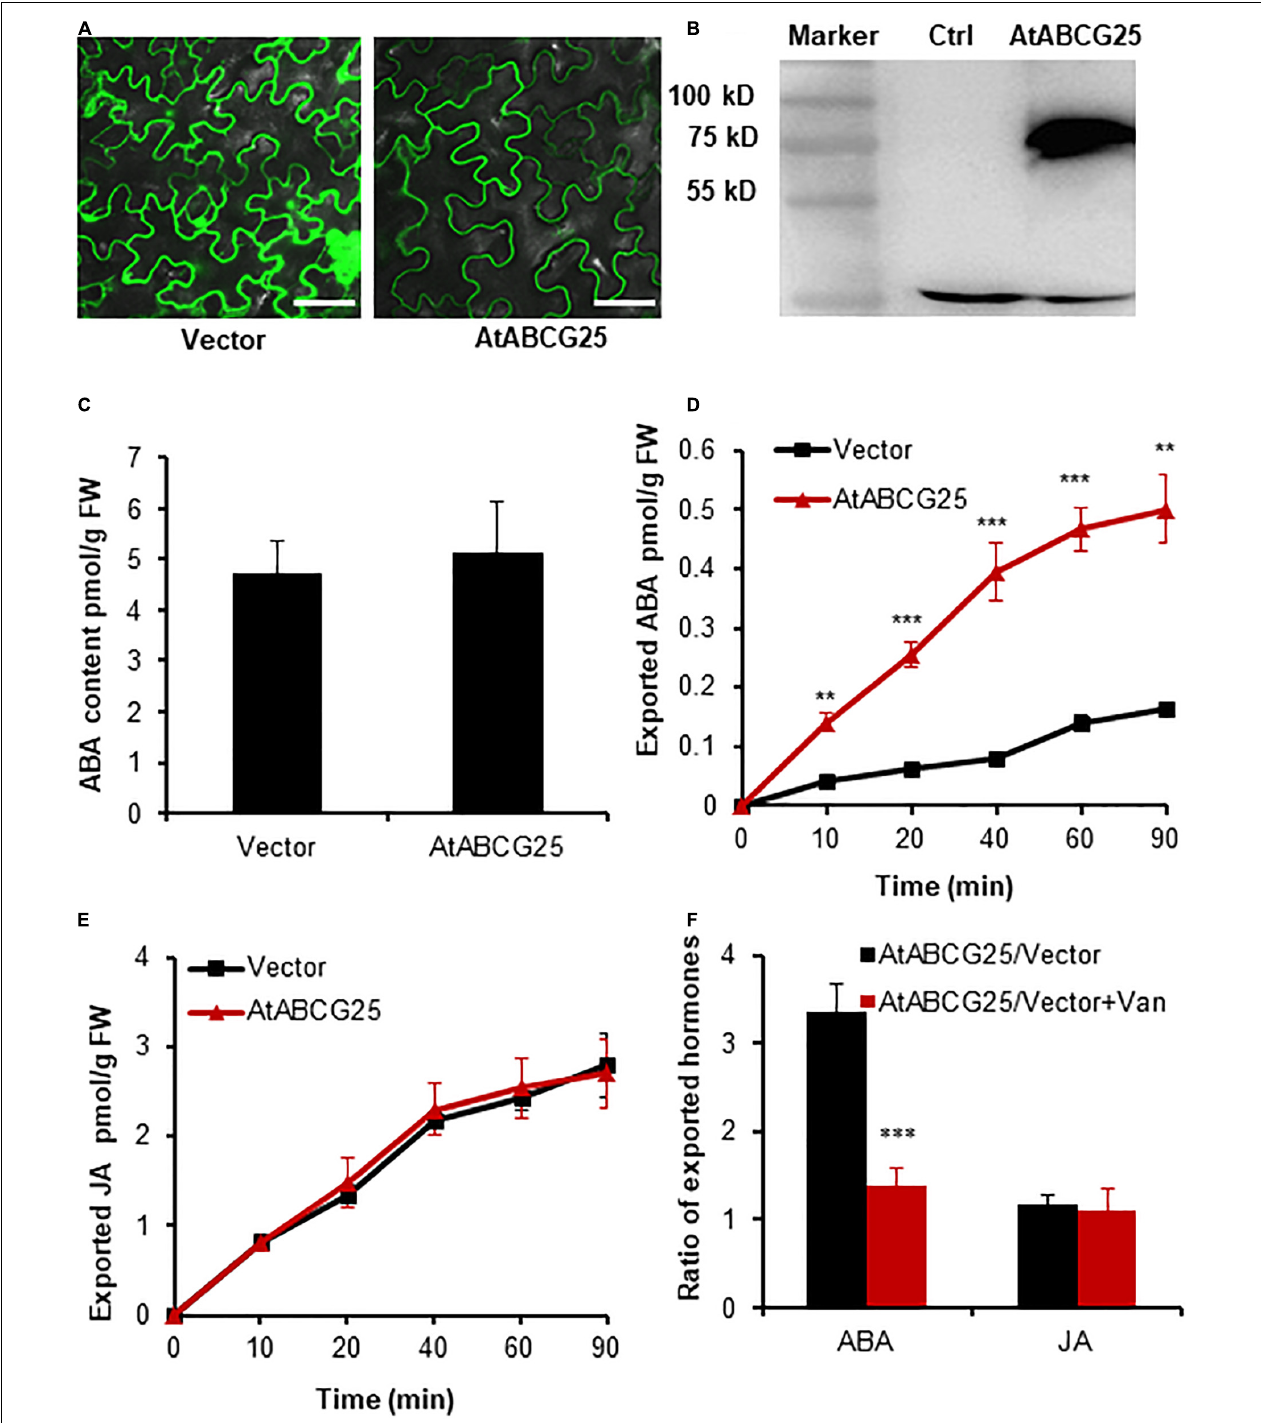
FIGURE 2 | AtABCG25-mediated efflux transport of ABA in agroinfiltrated tobacco leaves. (A) Transient expression of GFP and GFP-ABCG25 in tobacco leaves imaged by a confocal microscope. Bar = 50 µ m. (B) Immunoblot analysis of GFP - AtABCG25 fusion protein expression in tobacco leaves. M, marker; G25, total protein from tobacco leaves with transient expression of 35S:GFP-AtABCG25 ; Ctrl, control, total protein from non-transgenic tobacco leaves. (C) Quantification of ABA in tobacco leaves infiltrated with GV3101 harboring an empty vector and GFP-ABCG25 before efflux experiment. (D,E) Quantification of exported ABA (D) and JA (E) from tobacco leaves transformed with GFP-AtABCG25 and free GFP at the time points of 0, 10, 20, 40, 60, and 90 min. (F) The ratios of exported ABA and JA from tobacco leaves expressing GFP-AtABCG25 and free GFP in the presence or absence of 1 mM of sodium vanadate at 60 min. Data are means ± SE ( n = 4). *, **, and *** indicate P -values of P < 0.05, P < 0.01, and P < 0.001, respectively, from Student’s t -test.